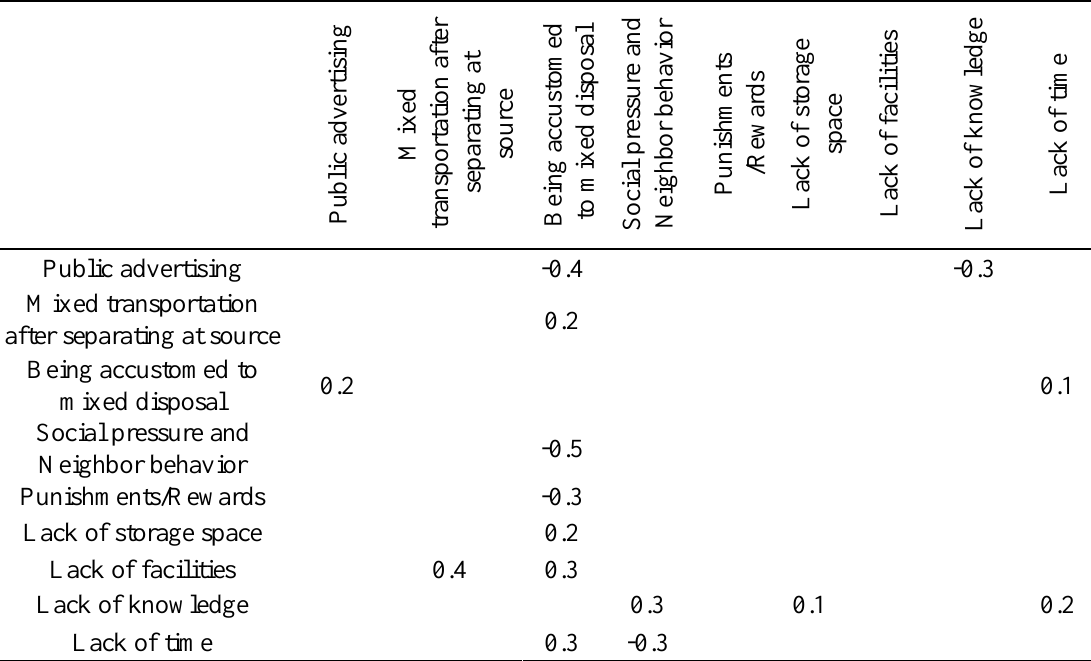
Figure 2. The network of the factors affecting waste separation at the source The yellow factors are variables that can be manipulated directly by the municipality. Also orange factors are variables that can’t be manipulated directly by the municipality. The effect percentage of the components shown in Fig. 2 on each other is shown in the table 2. Table 2. The rate of positive or negative